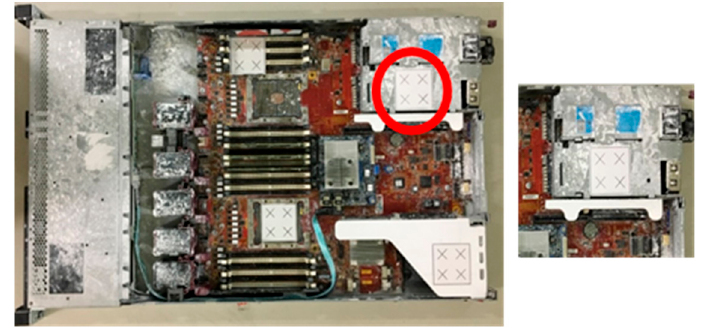
Figure 10. Object positioning system’s target object with artificial markers. The red circle shows the artificial marker (square containing four crosses) used for positioning. The remaining three markers were used to analyze positional errors after camera shooting.